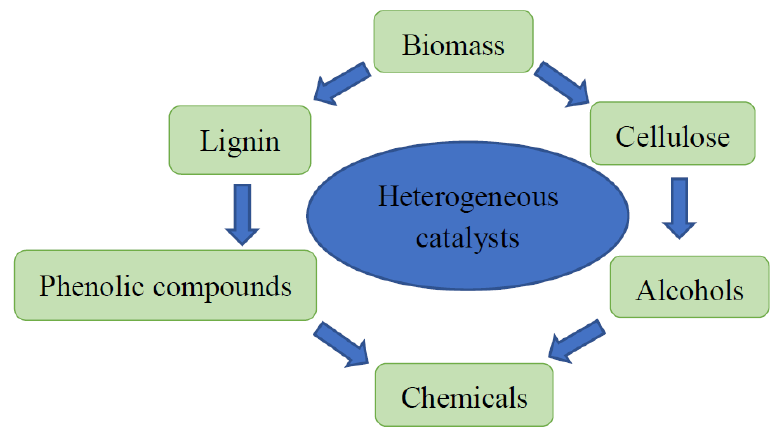
Figure 1. Chemical production via biomass-based transfer hydrogenation.